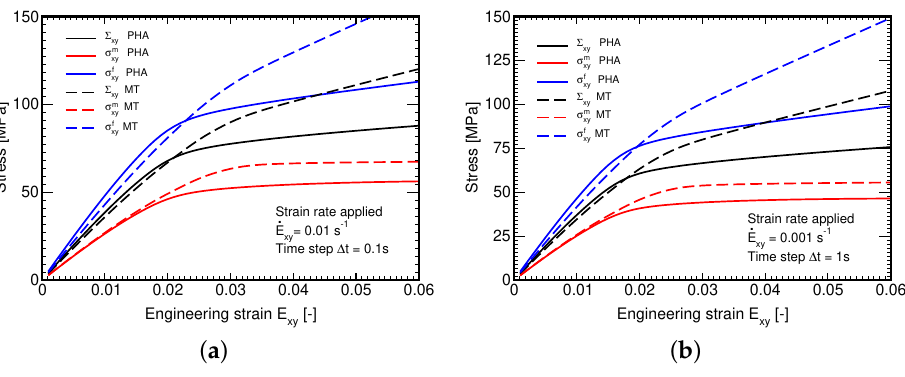
Figure 12. Local response (comparing FE and MT methods): ( a ) ˙ E xy = 10 − 2 s − 1 , ( b ) ˙ E xy = 10 − 3 s − 1 .